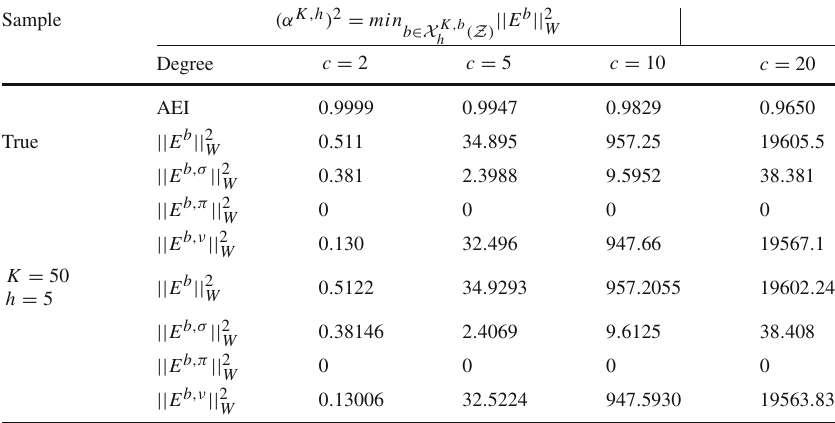
Table 4 Numerical approximation of the square of the minimal Slutsky norm of a set of extensions, for different sample size and different size of functional space of interpolators